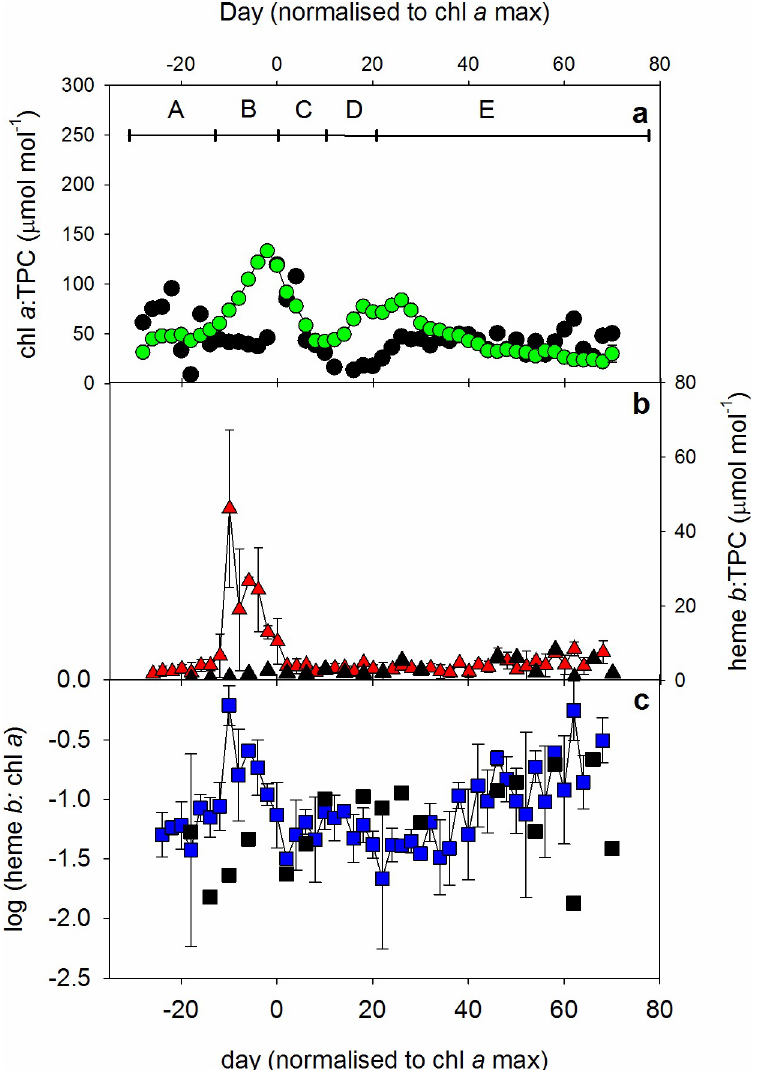
Fig 5. (a) Chlorophyll a : TPC, (b) heme b : TPC and (c) log(heme b : chl a ) ratios observed in the mesocosms (colouredsymbols) and fjord (black symbols) over time normalizedto the day of maximum chlorophyll a .